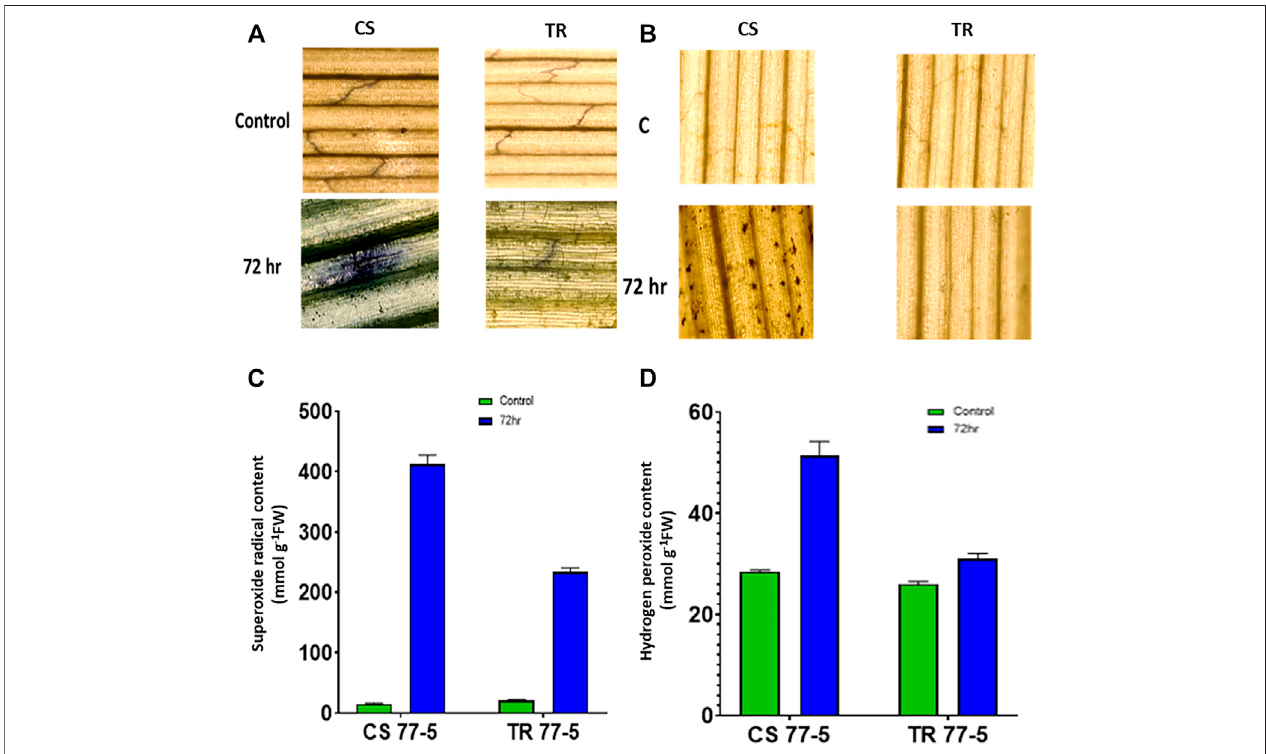
FIGURE 8 | Effects of leaf rust pathogen on the localisation and quanti fi cation of reactive oxygen species, superoxide radical (A,B) and hydrogen peroxide (C,D) . Chinese spring (CS) and introgression line of leaf rust resistance gene (Lr9) in CS, Transfer (TR). Leaf rust pathogen Puccinia triticina Eriks Pathotype 77-5 (121-R-63) uredospores were inoculated on 10 days old wheat seedlings and kept in a humidity chamber for 24 h. Leaf samples for analysis were collected at 0 h after inoculation (HAI), and 72 HAI. Values are mean (±SE) of three biological replicates.